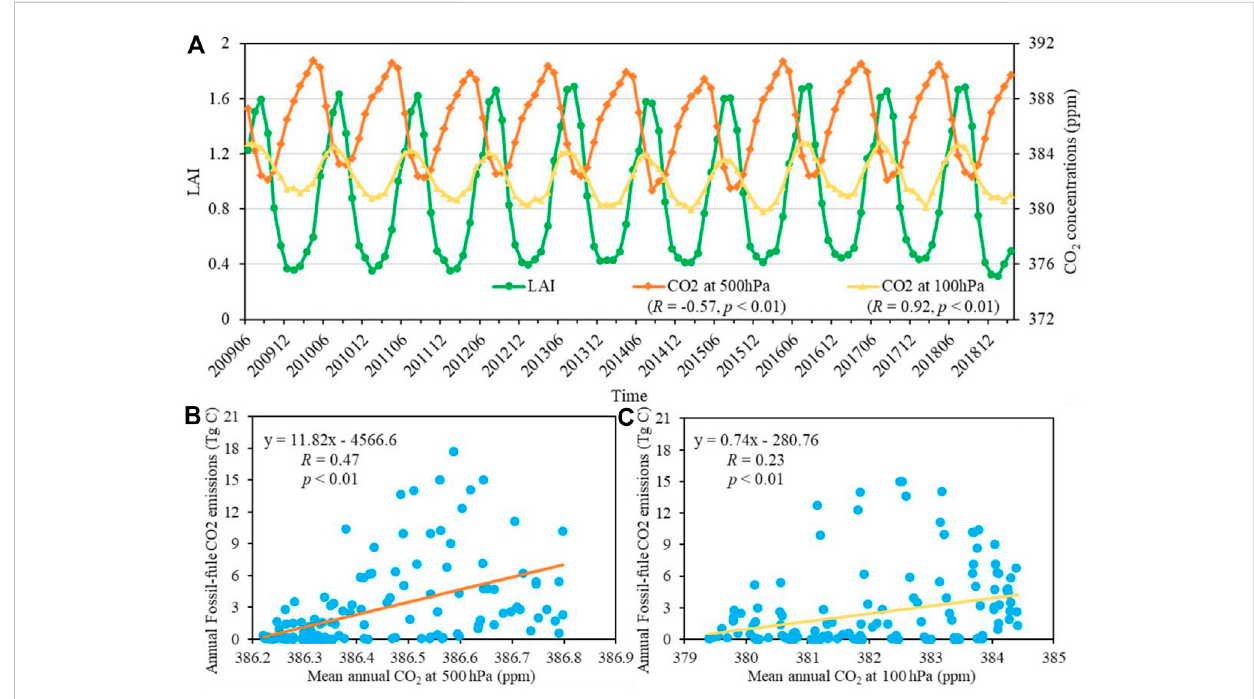
FIGURE 13 Interannual variability ofLAI andCO 2 (A) andthecorrelation analysis betweenCO 2 andfossil fuel emissions (B, C) atthemiddle (500 hPa)and upper (100 hPa) levels of the